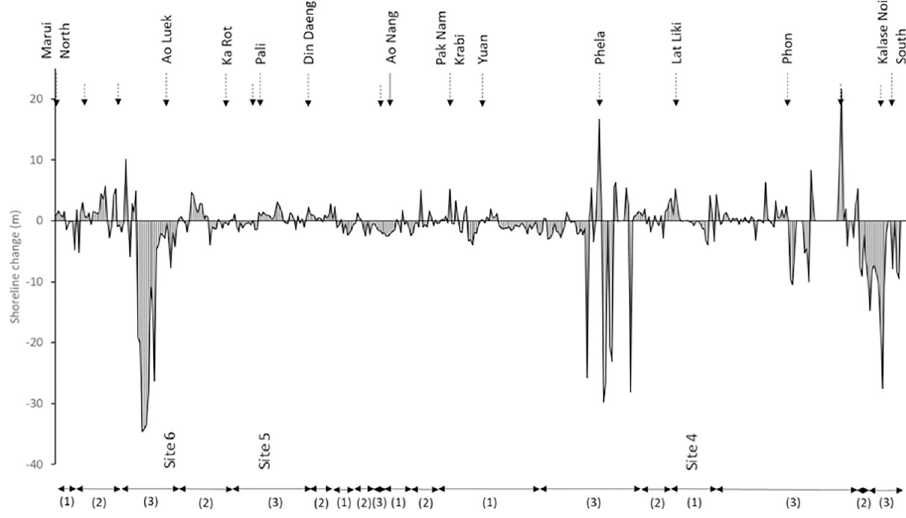
Fig 4. Shoreline change measured during the survey period along the mainland Krabi coastline. Dashed arrows indicate the location of major river outlets. Plain arrows are used for geographic locations. The total length of coast is 203.8 km. (1) shows a predominantly sandy beach coastline, (2) mostly rocky coast and (3) mostly mangrove coasts.